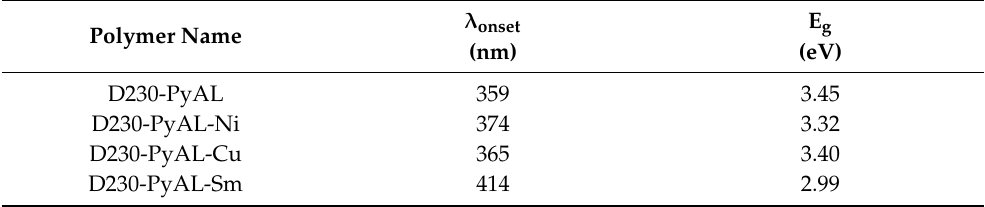
Figure 3. UV-Vis absorption spectra of polymers and coordination polymers. Table 1. UV-Vis data of polymers and coordination polymers.